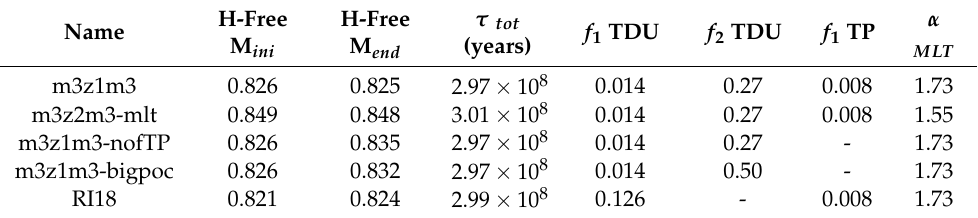
Table 2. Main properties of our 3 M (cid:12) asymptotic giant branch (AGB) models: H-free core mass at the beginning and the end of the AGB phase (in solar masses), total lifetime, convective boundary mixing parameters during thermal pulses (TP), and third dredge-up events (TDU) and the adopted mixing- length parameter α are given. Core masses, total lifetimes, and mixing parameters in RI18 for models with the same mass/metallicity combinations are also presented. MLT—mixing-length theory.